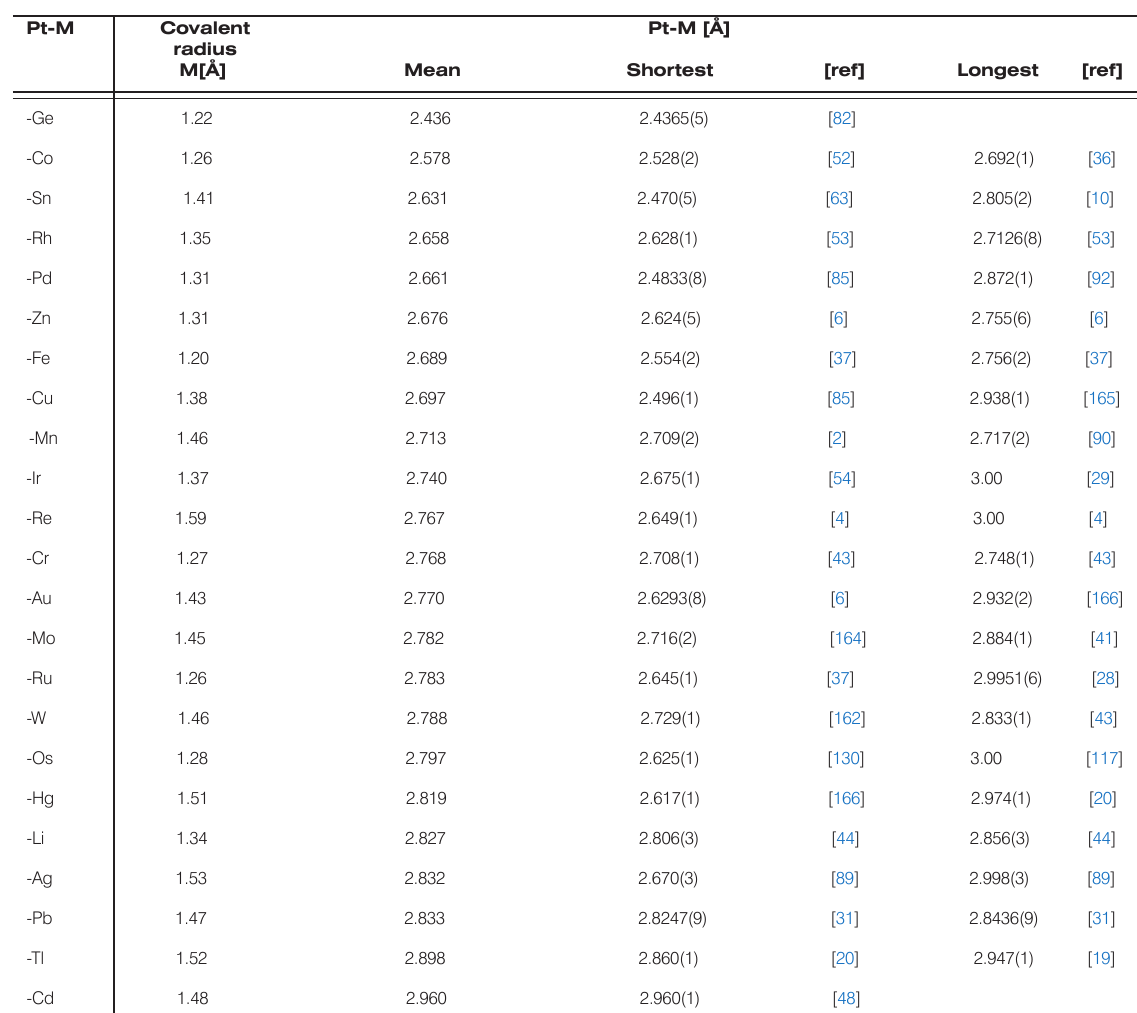
Table 6. Summary of Mean Pt-M bond distances for Heterotetranuclear